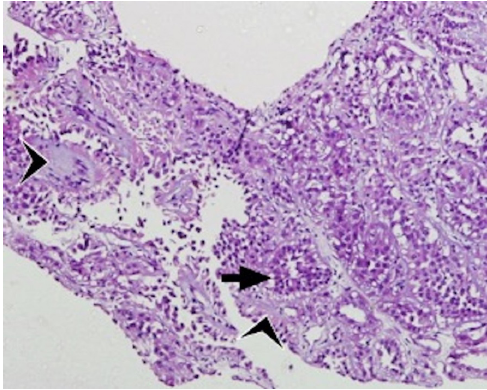
Figure 2: Tumor composed of tubules (arrow) with interven- ing mucoid matrix (arrowheads). H &